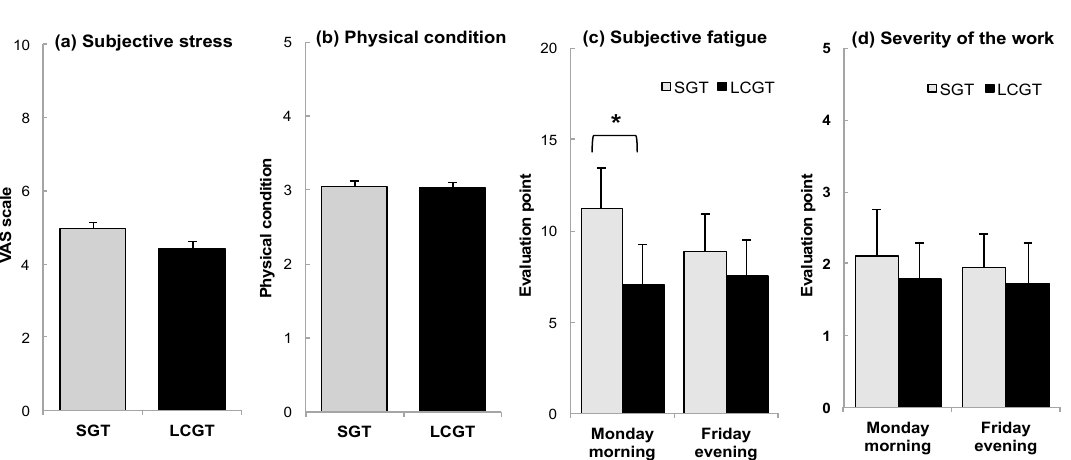
Figure 5. Effect of green tea ingestion on subjective stress and fatigue. ( a ) Subjective stress; ( b ) physical condition; ( c ) subjective fatigue; and ( d ) severity of work. Data are expressed as mean ± SEM ( n = 19, *, p < 0.05; one-way ANOVA).